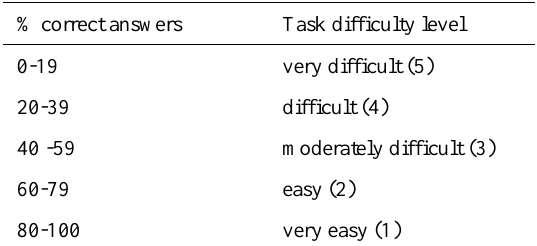
The assumed categories of the task difficulty level.